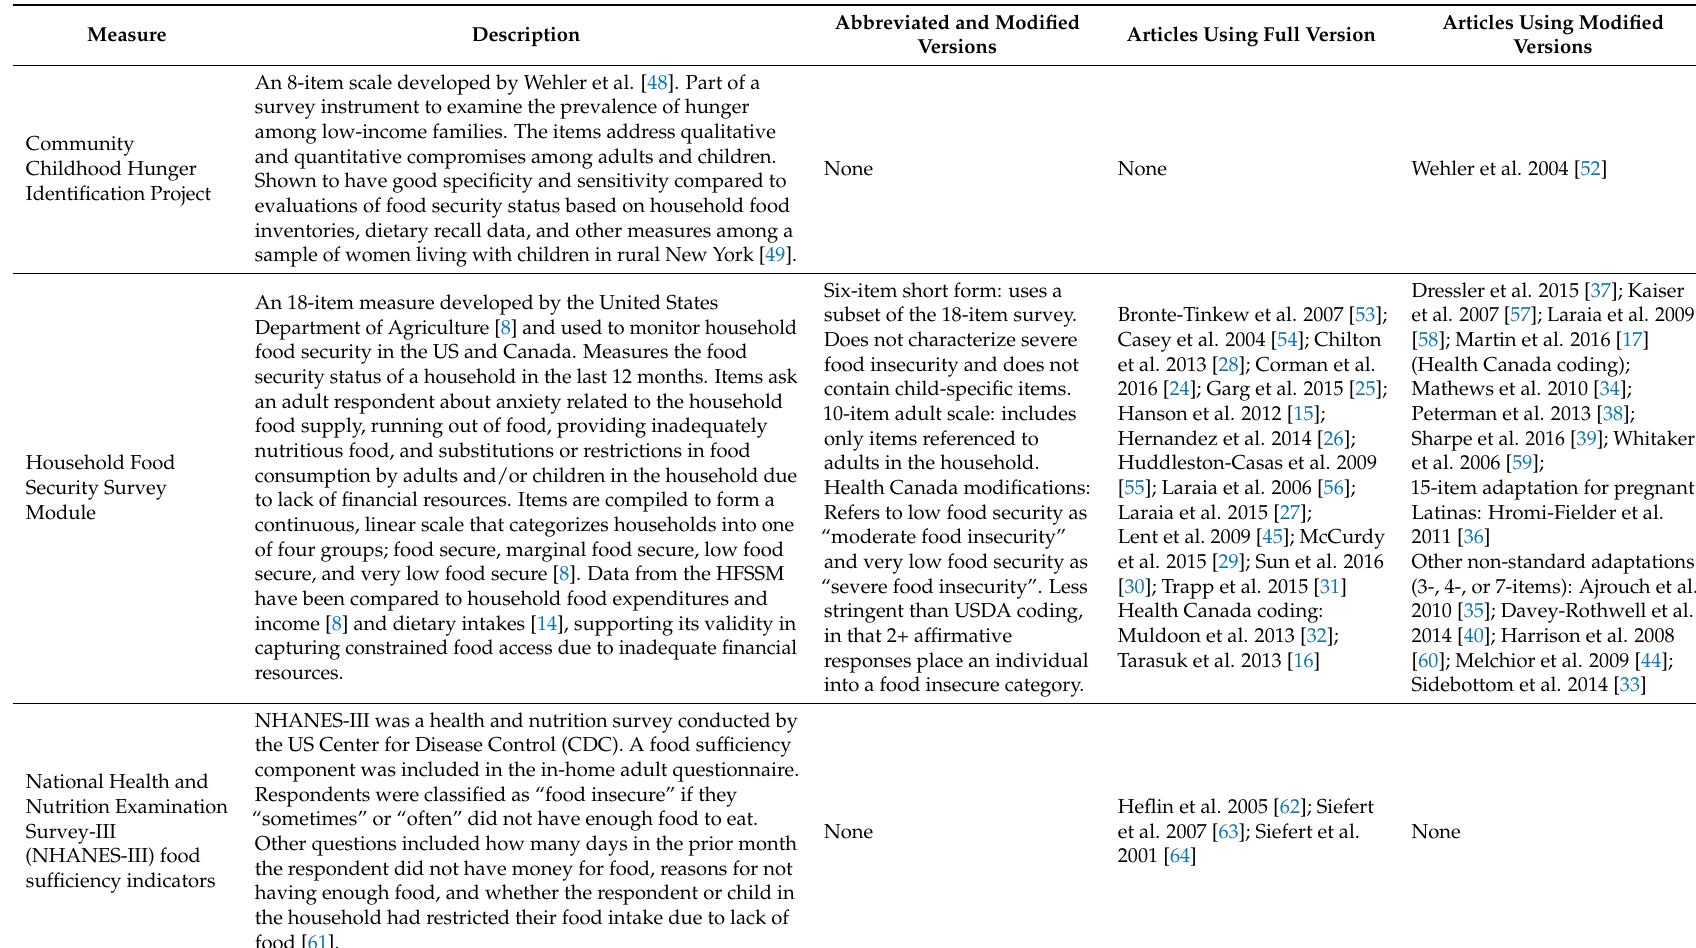
Table 1. Overview of measures of food security drawn upon in articles ( n = 39) examining associations between food insecurity and mental health among women in high-income